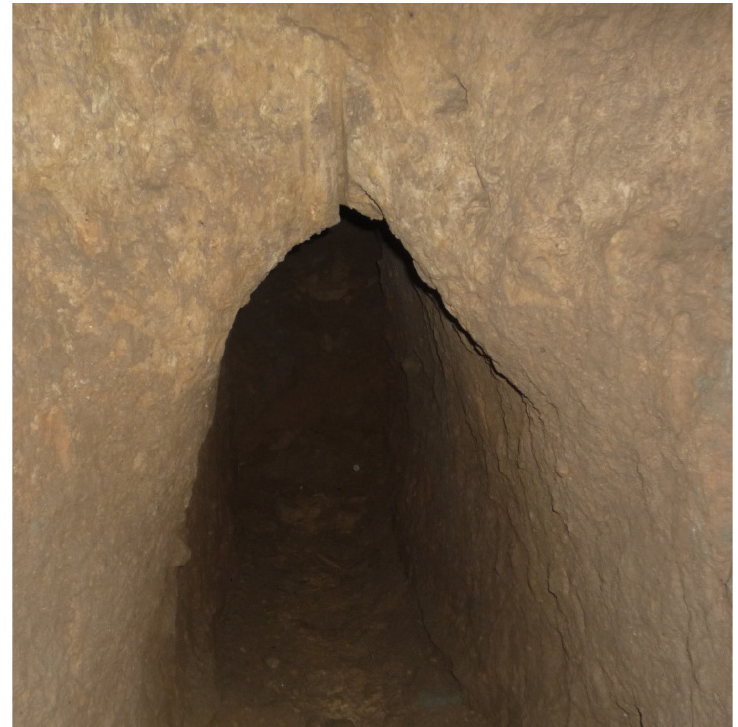
Figure 17. The tunnel of the aqueduct-like qanat in Nea Zichni constructed in the 18th